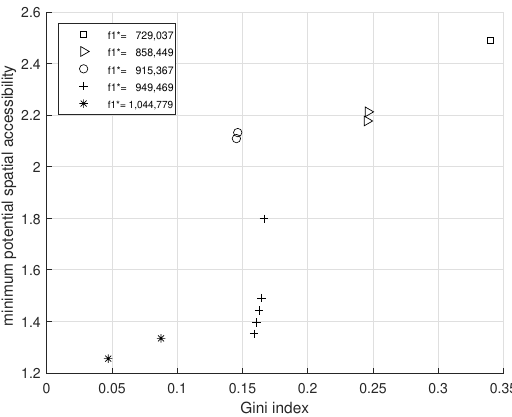
Figure 7. Spatial location of health centers for the indicated optimum coverage level f ∗